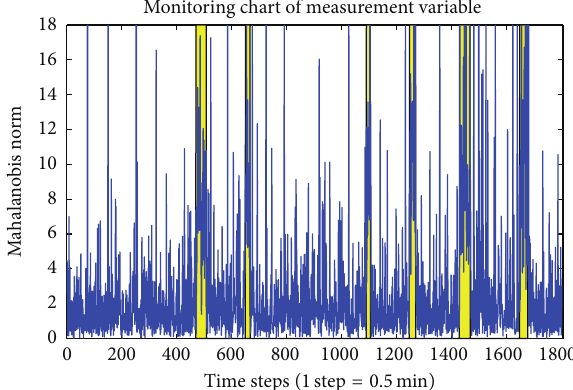
Figure 6: Monitoring chart of measurement